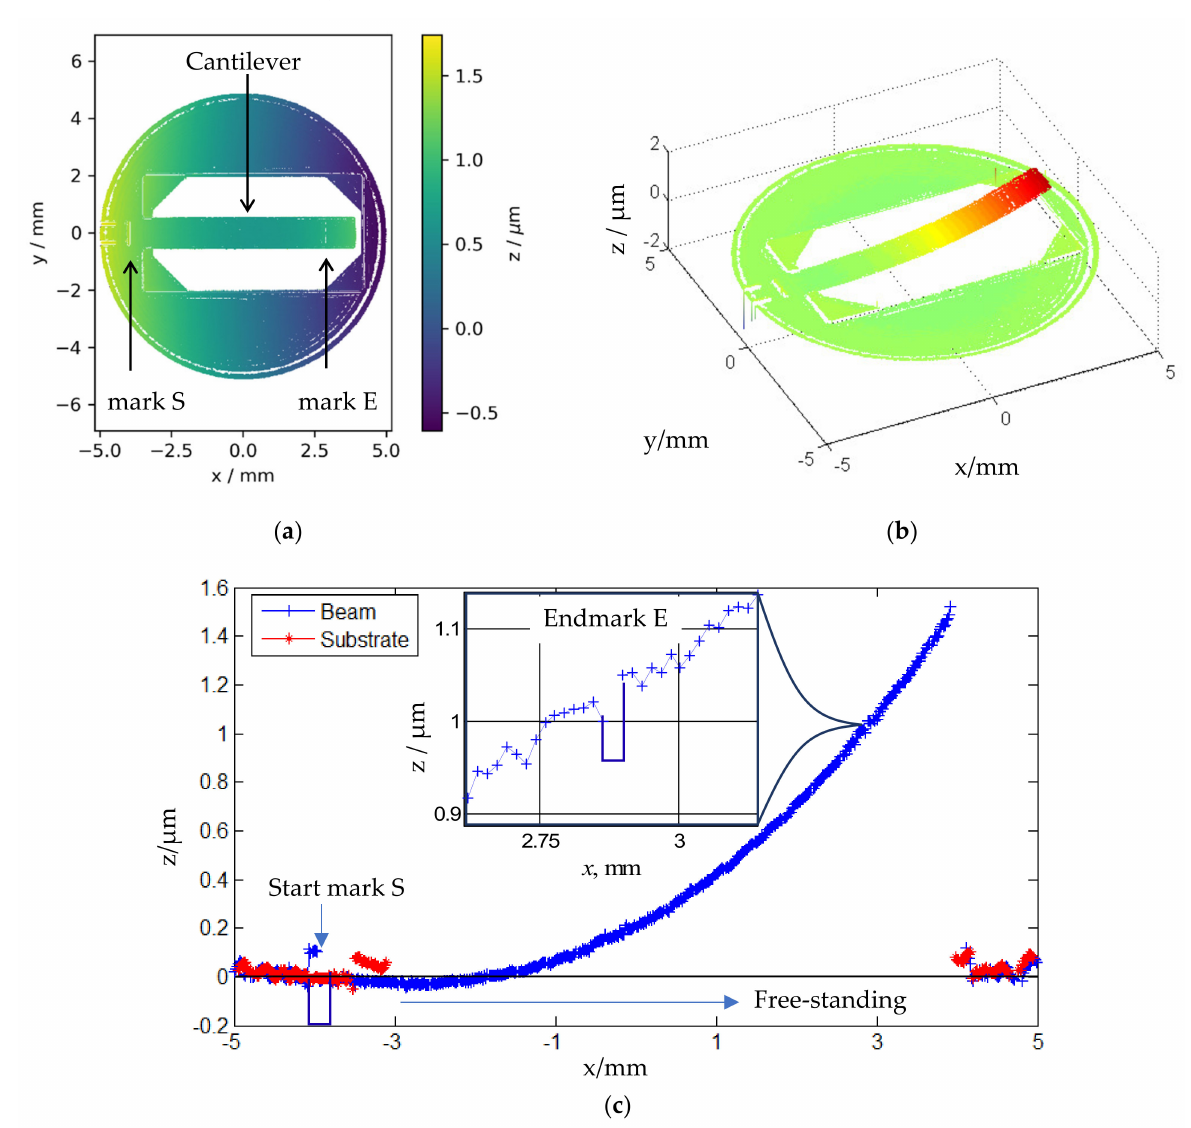
Figure 7. Topography measurement of a silicon microforce standard using a Fizeau interferometer: ( a ) 2D height map of the cantilever-based microforce standard; ( b ) 3D topography of the microforce standard; ( c ) Comparison between line profiles measured on the cantilever and parallel to the beam on the frame (substrate). (Note: Due to the inability of the interferometer to measure discontinuous surfaces, the profiles of step-like marks E and S cannot be rendered